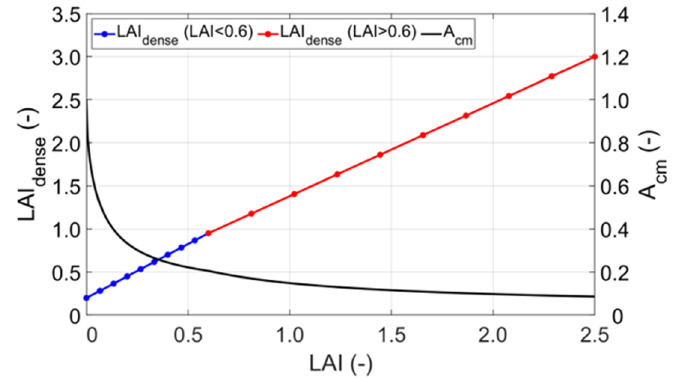
Figure 3. LAI dense and A cm values depending on LAI .